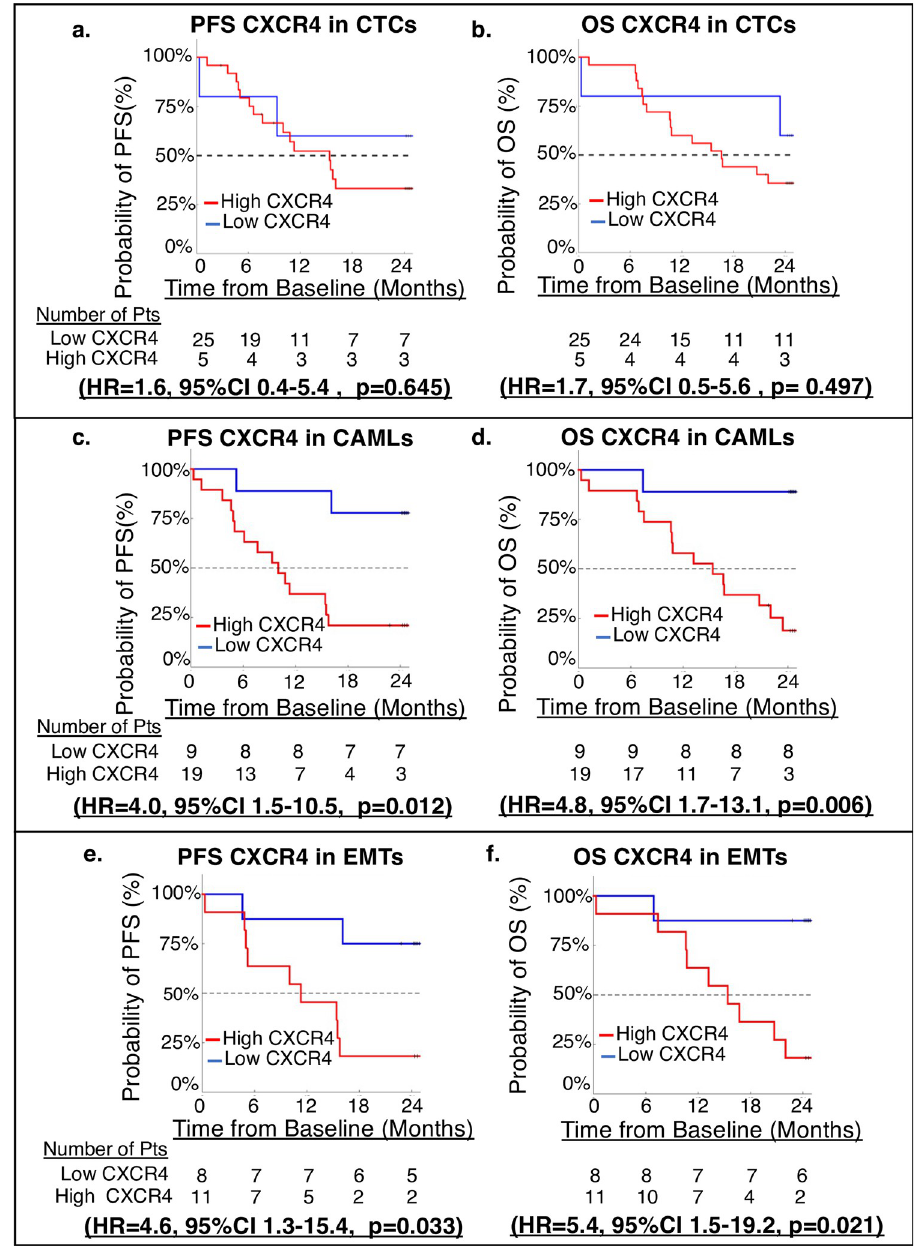
Fig 4. Kaplan-Meier graphs of PFS and OS for CTCs, CAMLs, and EMT expression. a. PFS of CTC CXCR4 Expression. b. OS of CTC CXCR4 Expression. c. PFS of CAML CXCR4 Expression. d. OS of CAML CXCR4 Expression. e. PFS of EMT CXCR4 Expression. f. OS of EMT CXCR4 Expression.